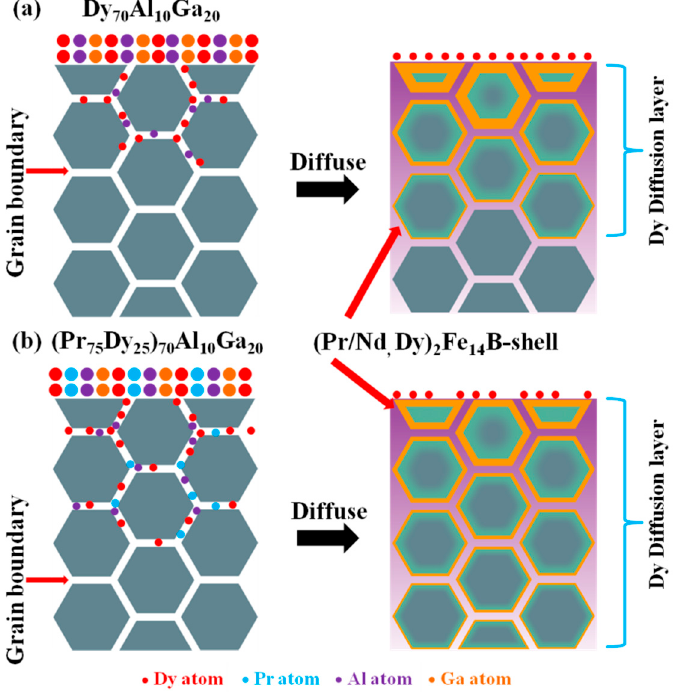
Figure 9. Schematic diagram of the Nd-Fe-B magnet diffused structure. ( a ) the Dy 70 Al 10 Ga 20 diffused magnet; ( b ) the (Pr 75 Dy 25 ) 70 Al 10 Ga 20 diffused magnet.